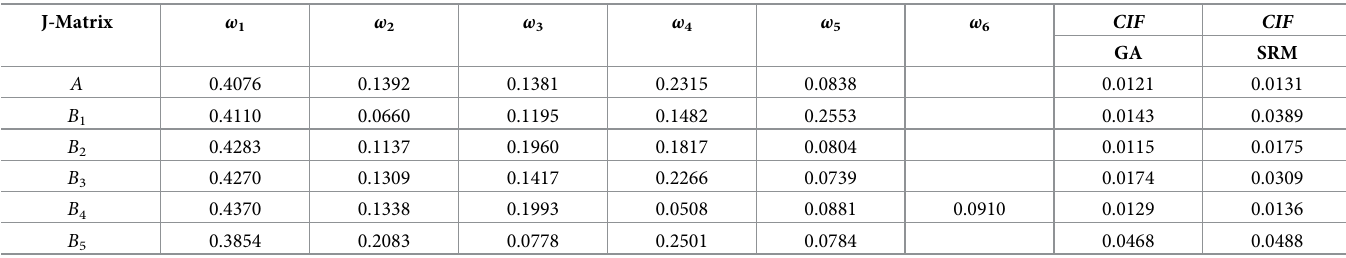
Table 2. Calculations of the